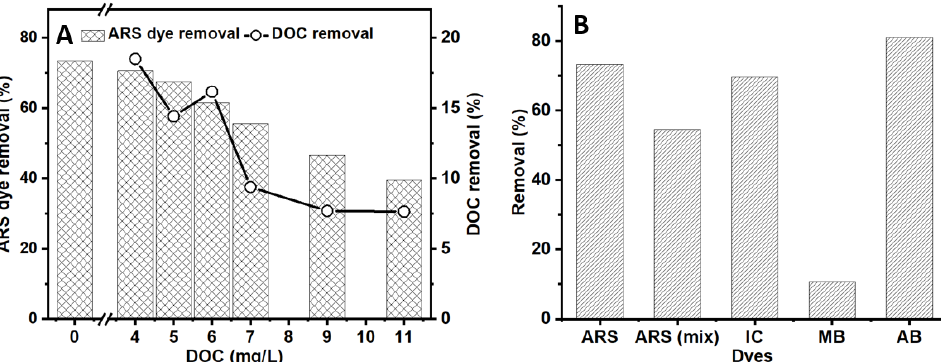
Figure 5. ( A ) Influence of DOM (as DOC) concentration on the removal of ARS dye and DOC by the MCN (experimental conditions: DOC concentration, 4–11 mg/L; solution pH, 6.8; ARS dye concentration, 10 mg/L; MCN dosage, 25 mg; contact time, 60 min); ( B ) Removal of different dyes using MCN (experimental conditions: solution pH, 6.8; dye concentration, 10 mg/L; MCN dosage, 25 mg; contact time, 60 min).